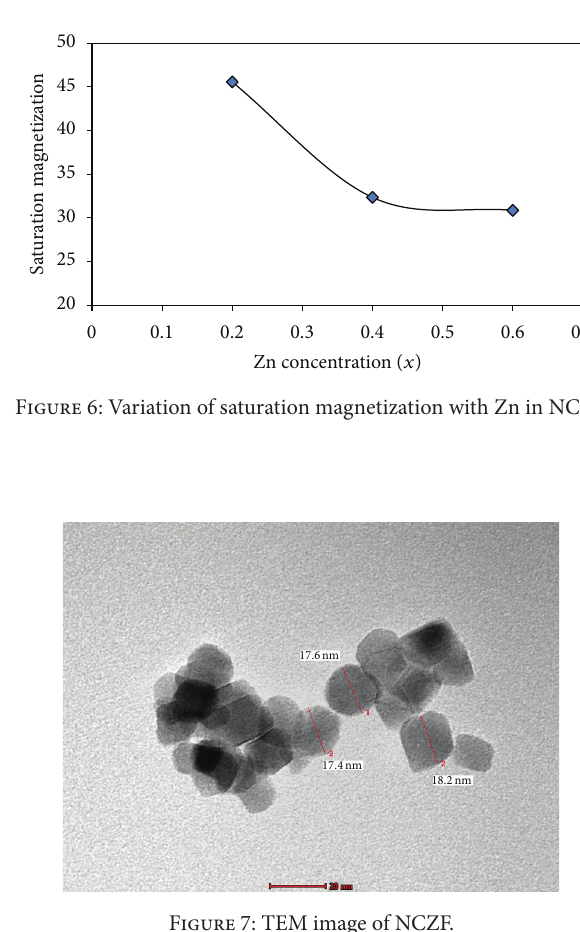
Figure 7: TEM image of NCZF.